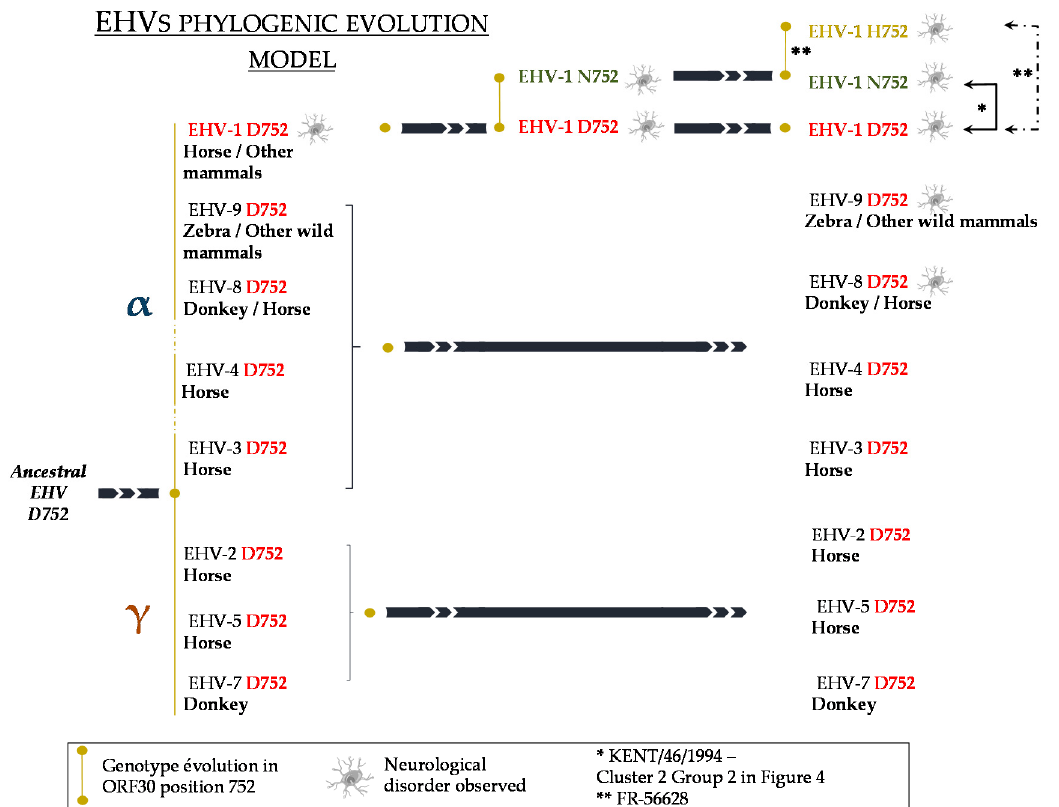
Figure 9. Possible evolutionary model for equid herpesviruses. Reverse evolution is shown with black arrows and illustrated with strains from the current study (KENT/46/1994 (*) and FR-56628 (**)).